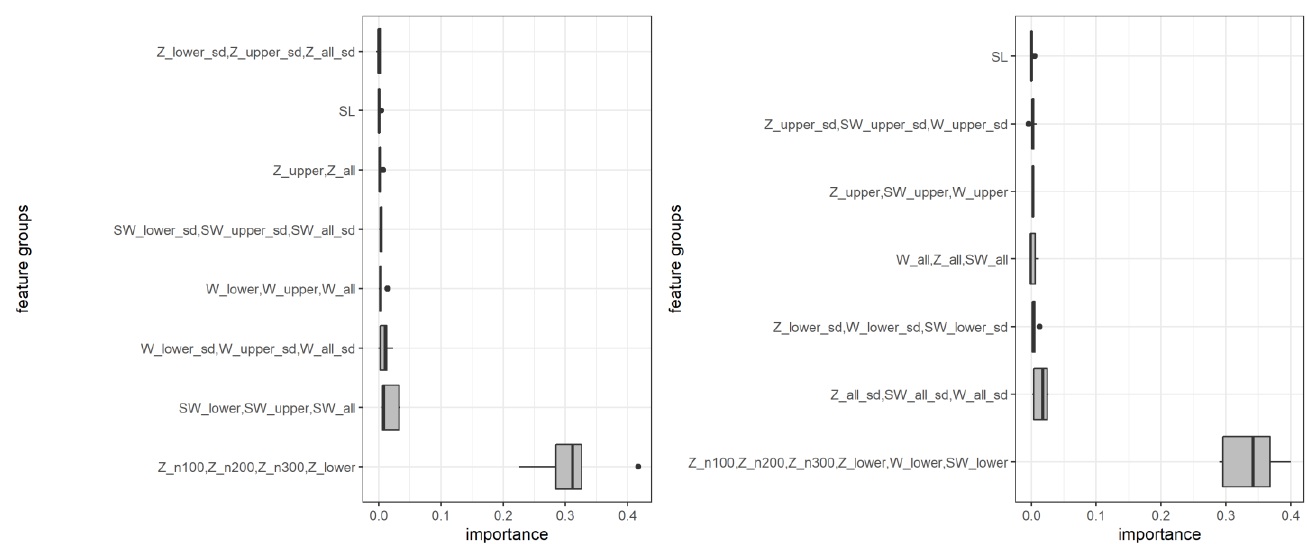
Figure A1. Importance of user-defined feature groups ordered by the mean value of permutation feature importance (PFI) for all 5 folds of the cross-validation.